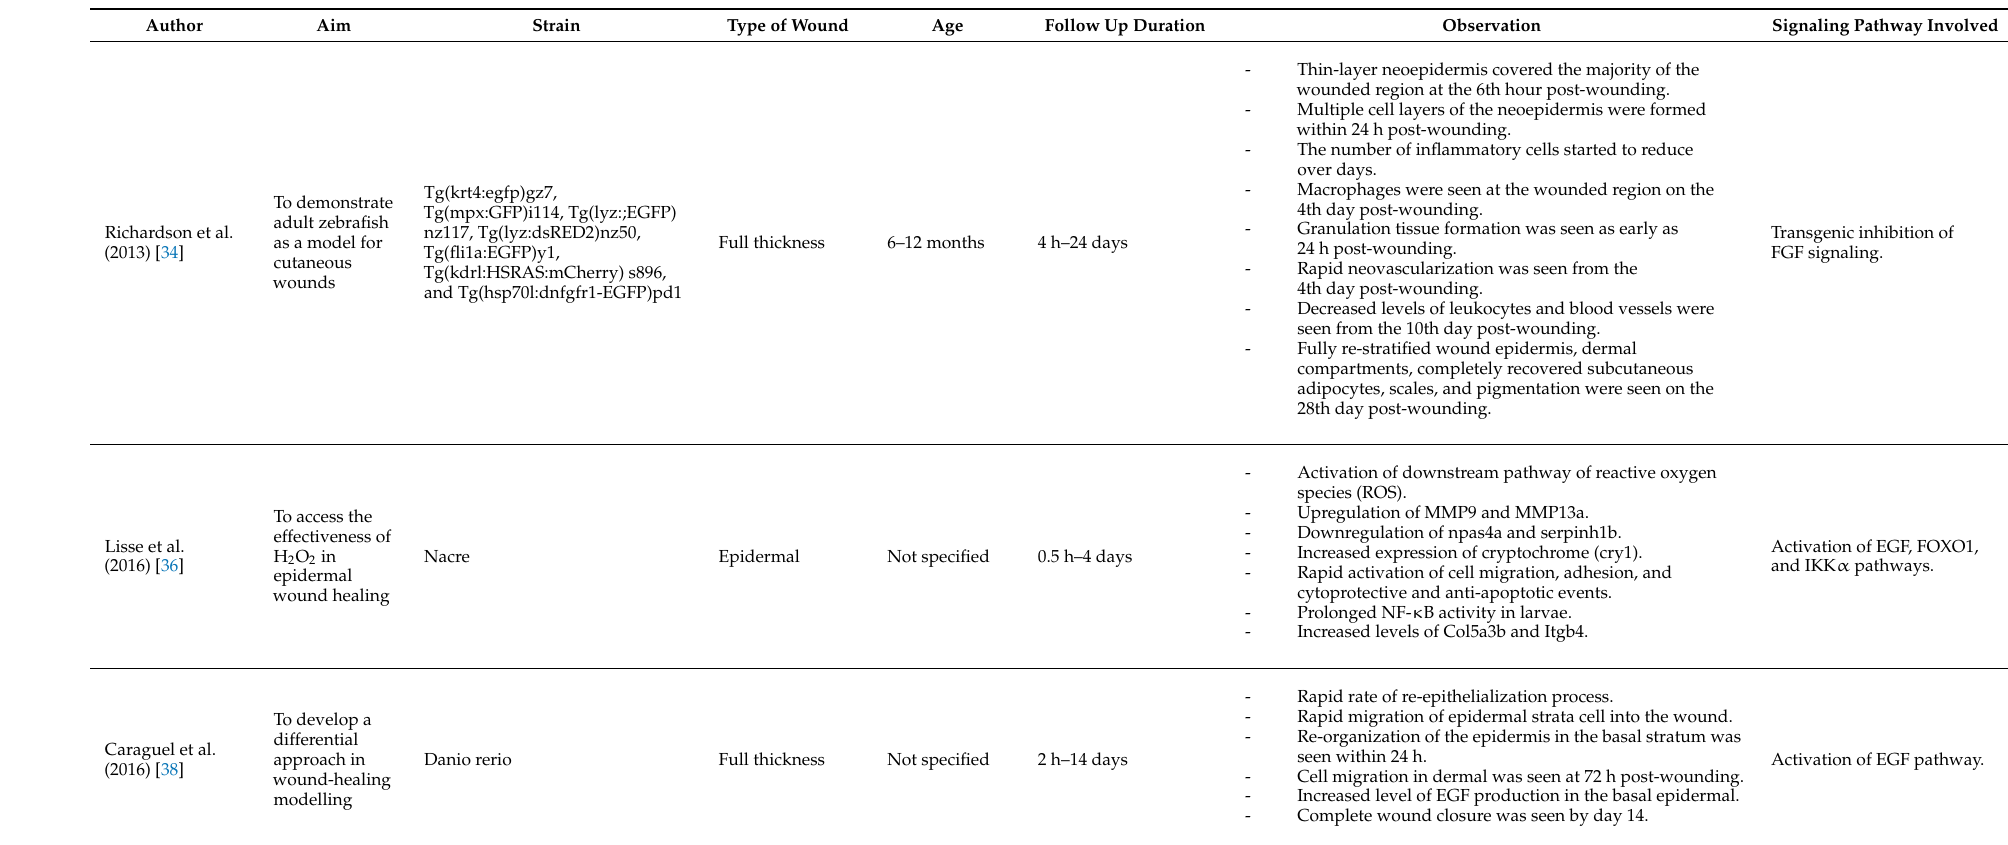
Table 1. In vivo evidence.